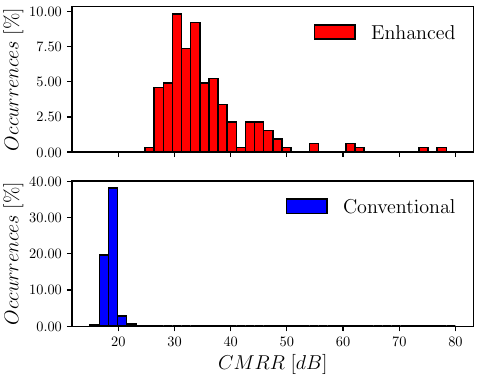
Figure 15. CMRR comparison between the two D2S-based OTA solutions: red color, the enhanced one; blue color, the conventional